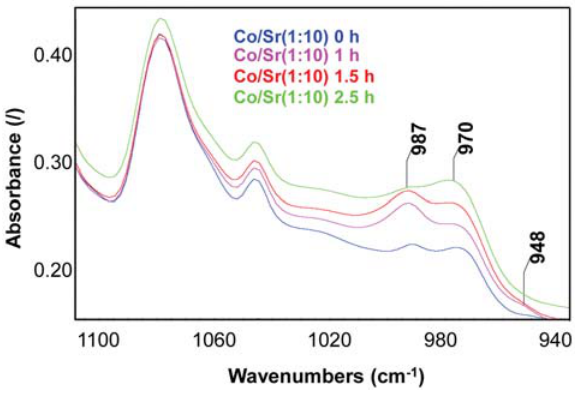
Figure 6. Detailed and shifted FT-IR spectra of HS alkyd coatings with Co/Sr (1:10) drier- combinations versus time.